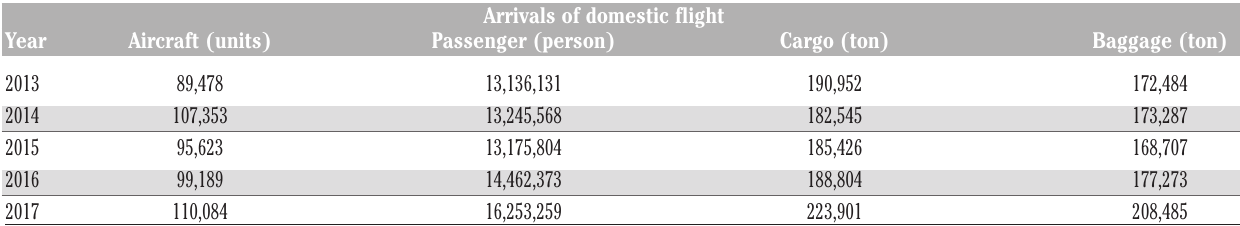
Table 2. Arrivals of aircraft, passengers, cargo and baggage of international flight, 2013-2017. 8